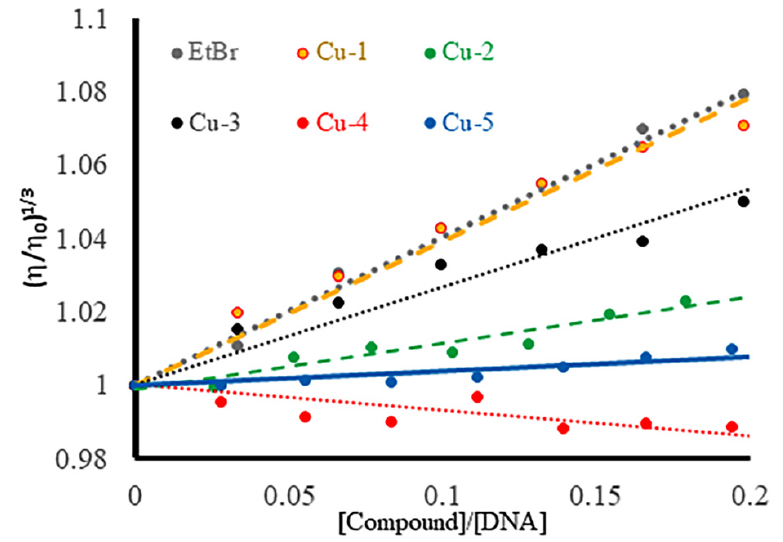
Figure 7. Determination of the binding modes of the compounds to DNA by viscosity assay.